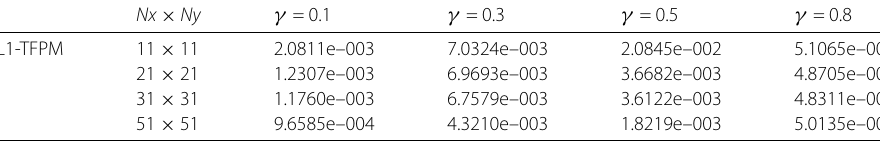
Table 5 The error of L1-TFPM in the paper Nx × Ny